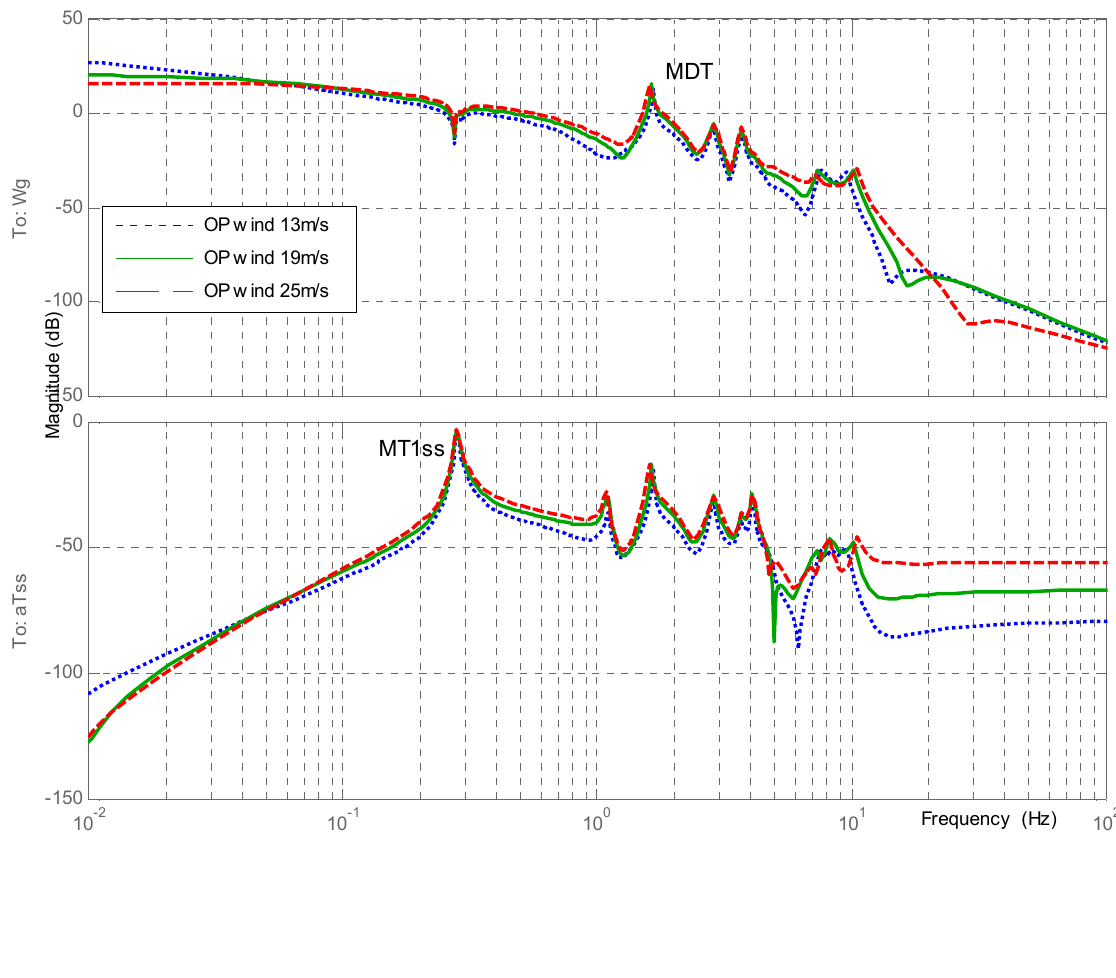
Figure 5. Family of plants for the H